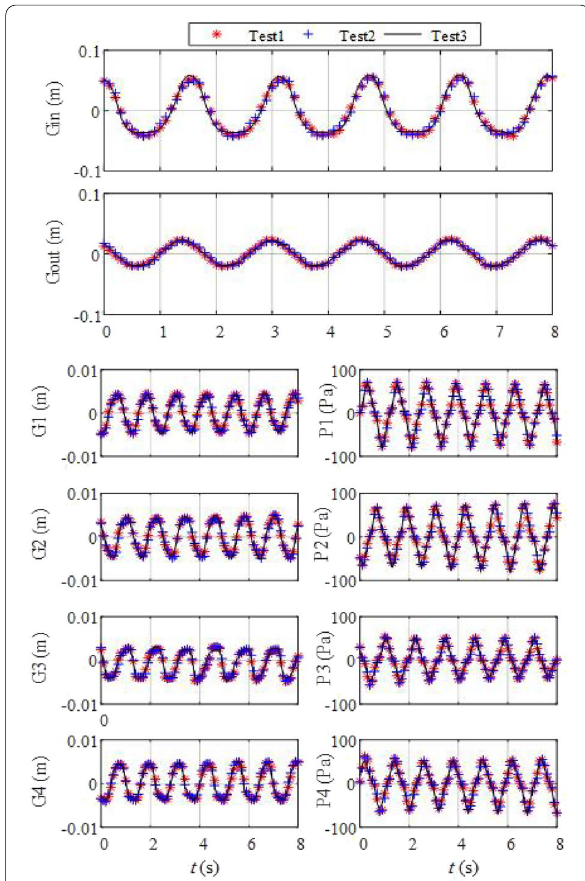
Figure 14 Sample TIME-series data of the experiment repeatability for a wave condition of H opening ratio of R i